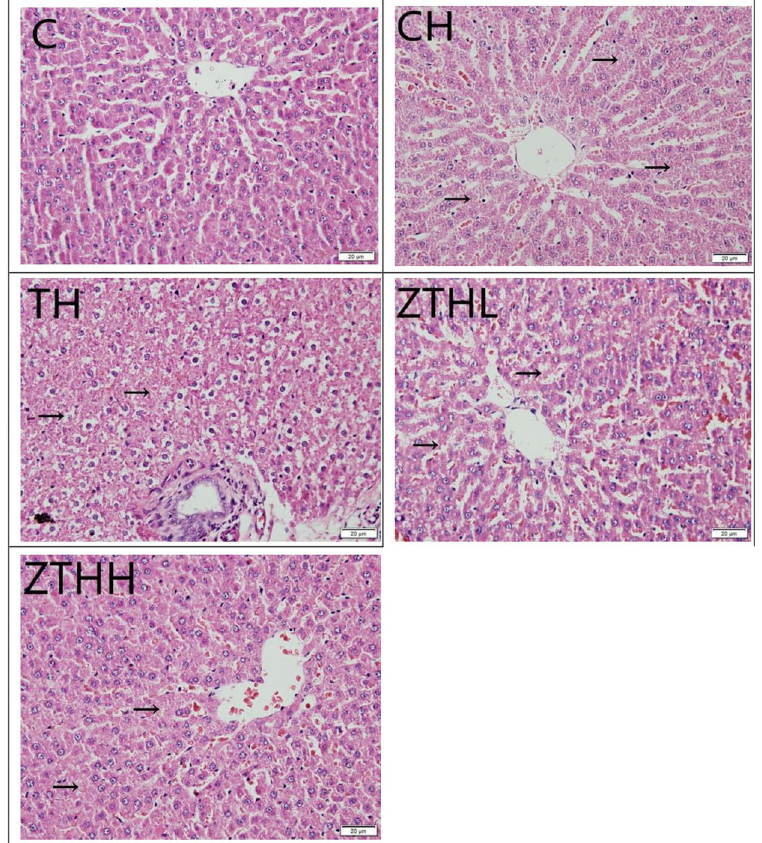
Figure 9. The histological features of liver in experimental rats (400 × ). Liver tissues from SD rats were stained with hematoxylin and eosin. Arrow: dropsy, necrosis, and disorder of liver